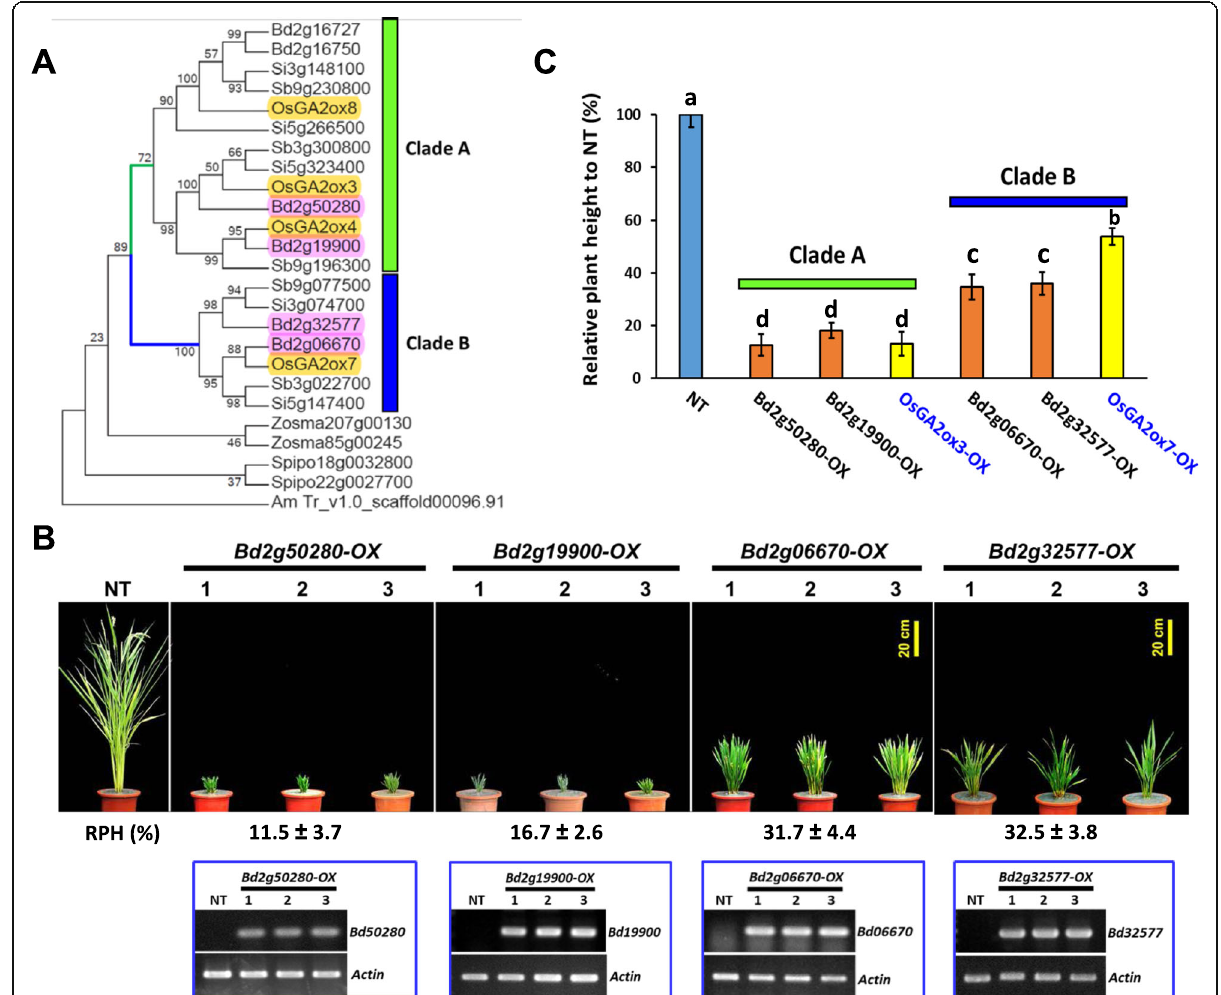
Fig. 5 Two functionally distinct clades of class I GA2ox genes in monocots according to phylogenetic analysis and their functional identifications. a Phylogenetic analysis of class I GA2ox genes in monocots revealed two functionally distinct clades. b Functional identification of orthologous genes of Bd2g50280 (orthologous to OsGA2ox3 ), Bd2g19900 (orthologous to OsGA2ox4 ), Bd2g06670 (orthologous to OsGA2ox7 ), and Bd2g32577 (orthologous to OsGA2ox10 ) from B. distachyon. Three representative T 0 transgenic rice plants from each of the transgenic overexpression lines and their average RPH are shown. Values are means ± SE ( n = 5). The RT-PCR analysis results for each target gene of three independent transgenic lines are shown. The Actin gene was used as a control. c Statistical comparisons of RPH between clades A and B as a result of the orthologous genes from B. distachyon and rice. Values are means ± SE ( n = 5). The different letters indicate significant differences between samples according to the Turkey ’ s HSD test ( p <